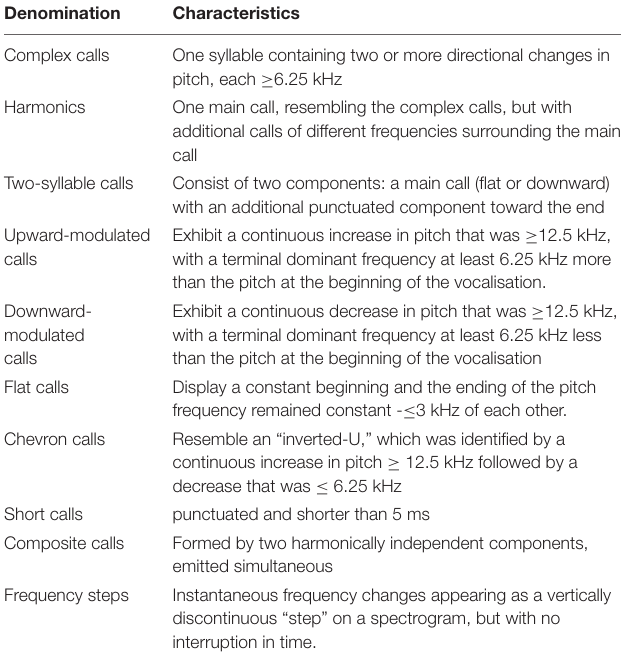
TABLE 1 | Different types of ultrasonic vocalisations (Scattoni et al.,